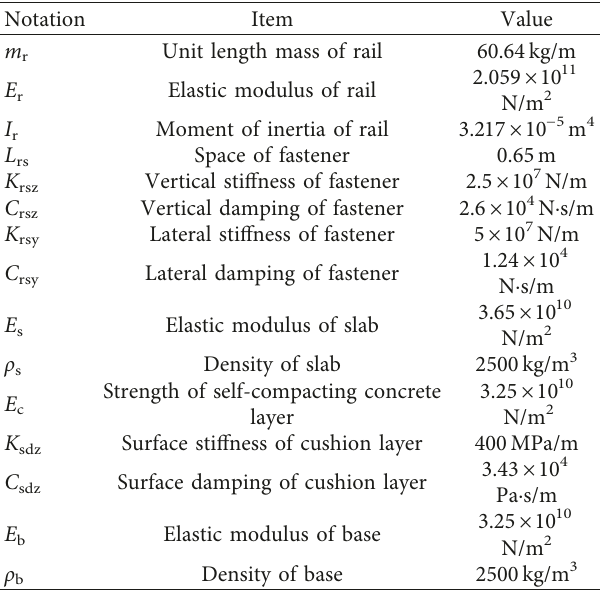
Figure 1: The dynamic model for the vehicle-CRTS III slab track system. (a) Face view. (b) Side view. Table 1: The parameters of